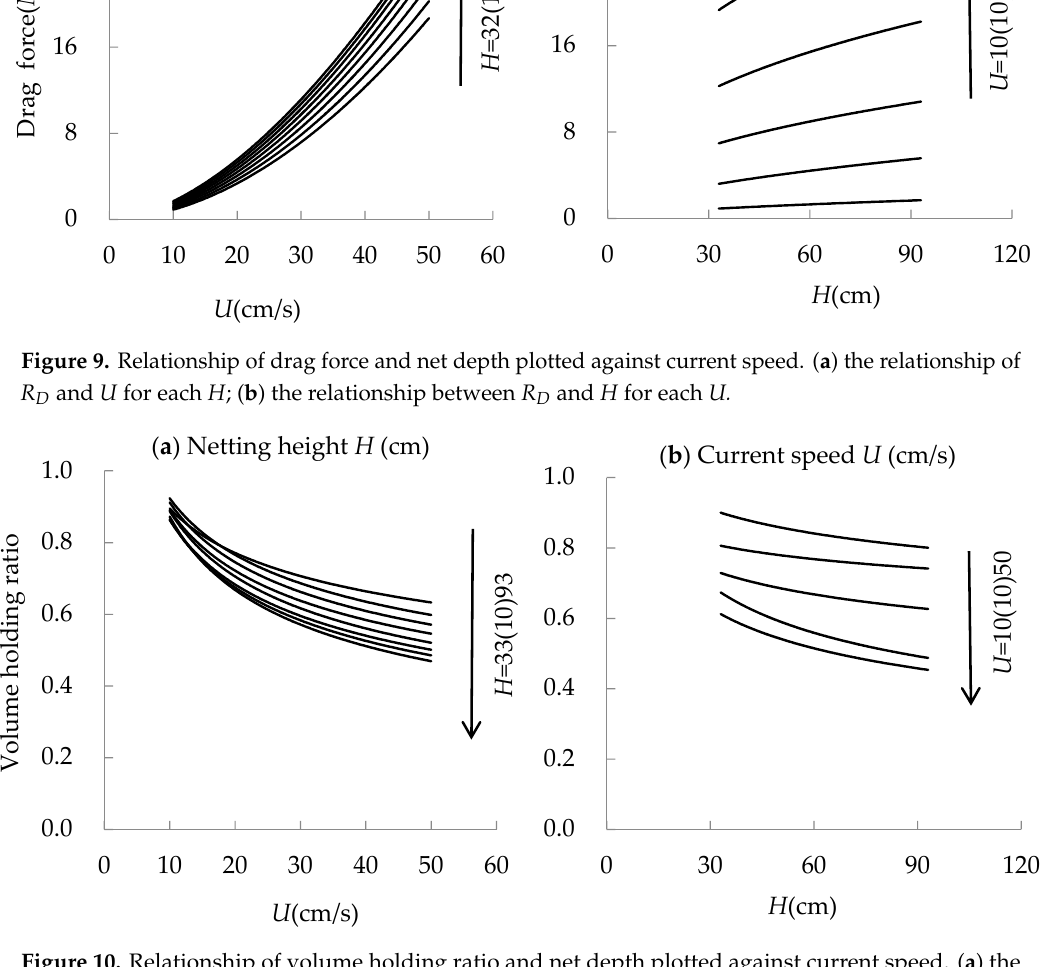
Figure 10. Relationship of volume holding ratio and net depth plotted against current speed. ( a ) the relationship of C v and U for each H ; ( b ) the relationship between C v and H for each U.